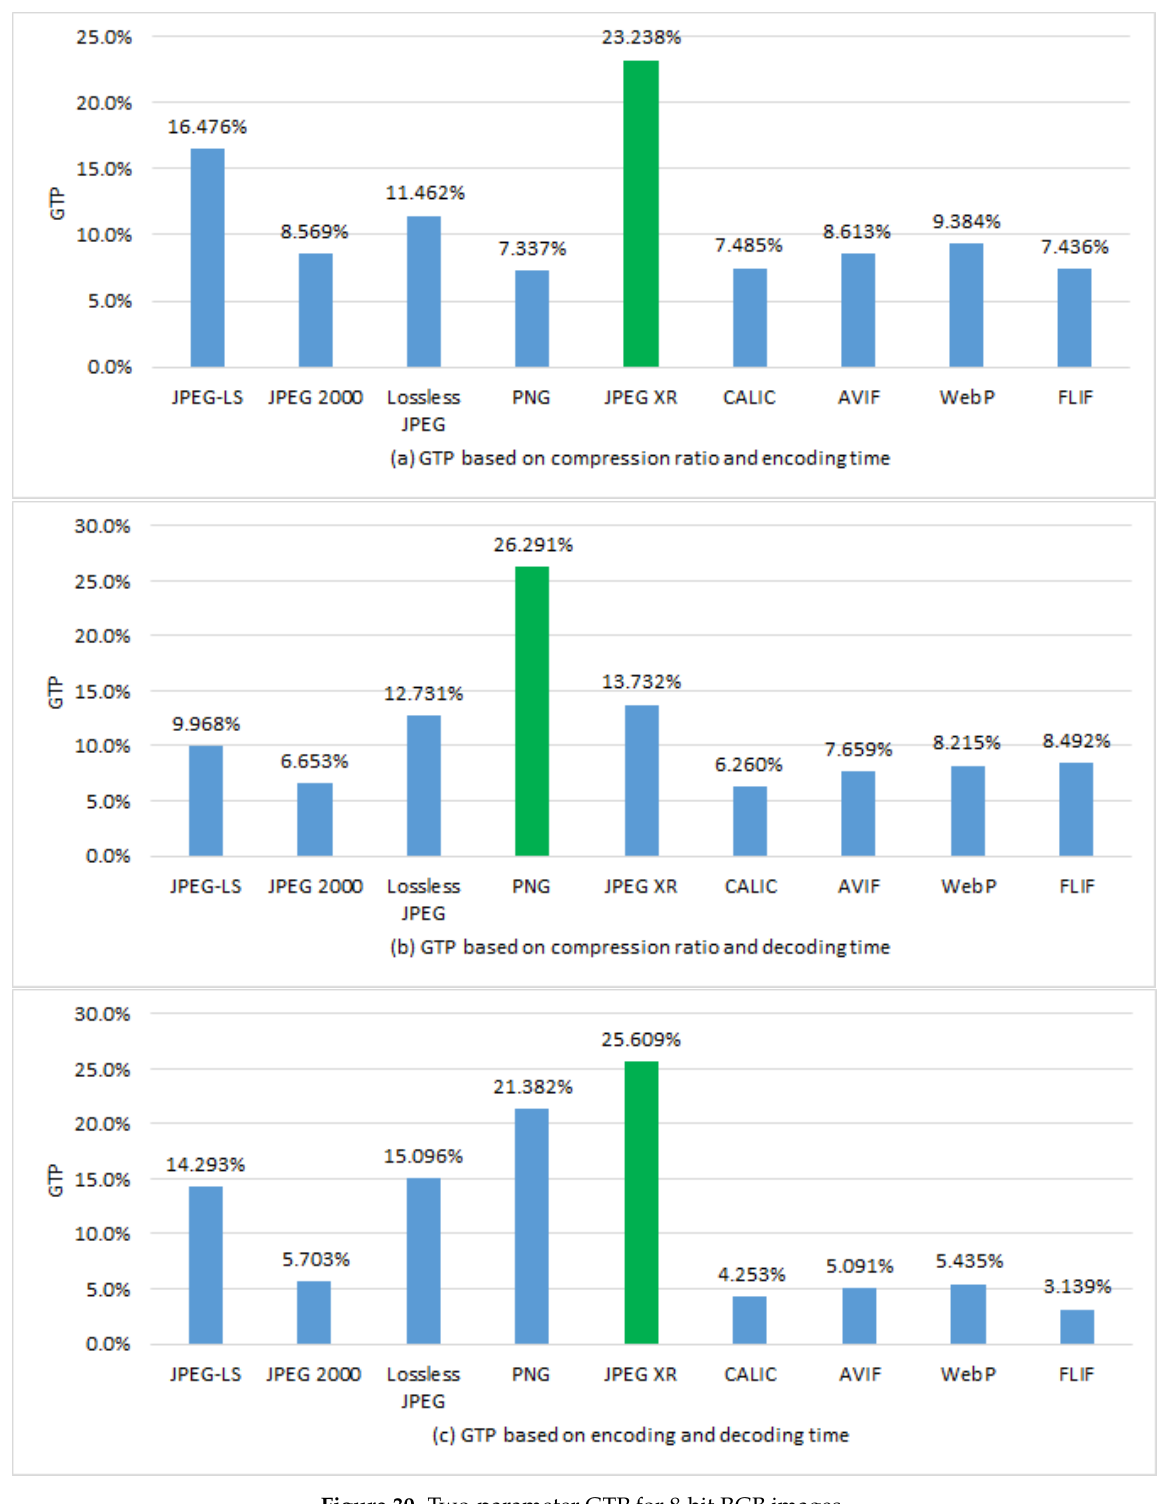
Figure 30. Two-parameter GTP for 8-bit RGB images. For 16-bit greyscale images, Figure 31 shows the two-parameter GTP for the state-of- the-art techniques. In terms of CR and ET , JPEG XR achieves the highest GTP